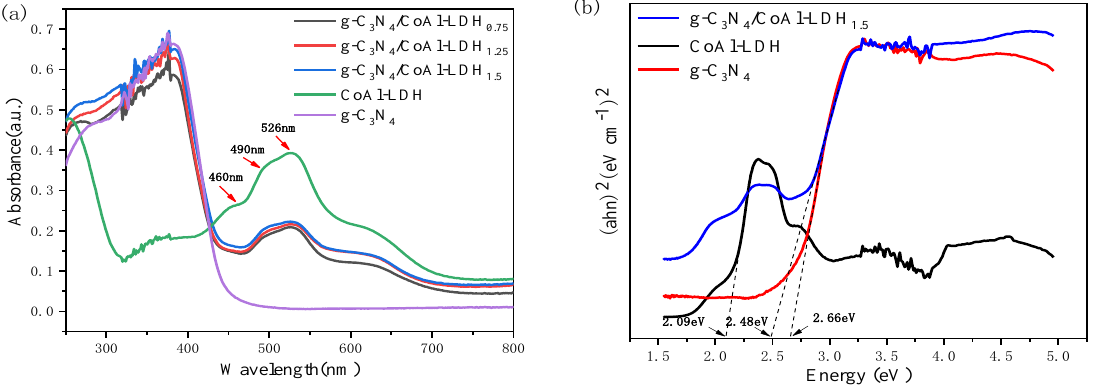
Figure 5. ( a ) UV-VIS absorption spectra of g-C 3 N 4 , CoAl-LDH, and the g-C 3 N 4 /CoAl-LDH nanocom- posites; ( b ) Tauc plot of g-C 3 N 4 , CoAl-LDH, and the g-C 3 N 4 /CoAl-LDH 1.5 nanocomposite.